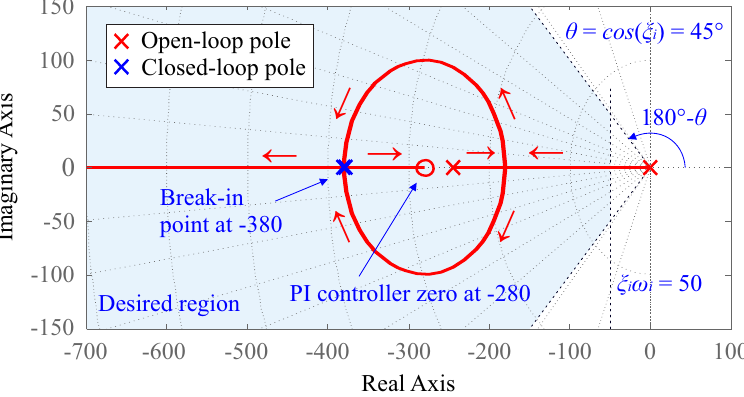
Figure 9. Root locus for current control